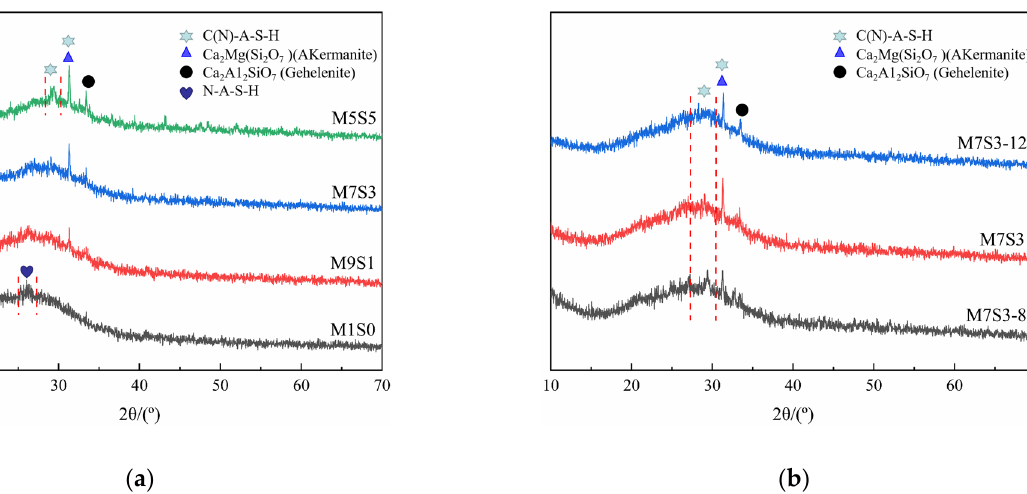
Figure 7. XRD patterns of AAMS composite cementitious materials. ( a ) Different slag contents. ( b ) Different Na 2 O contents.